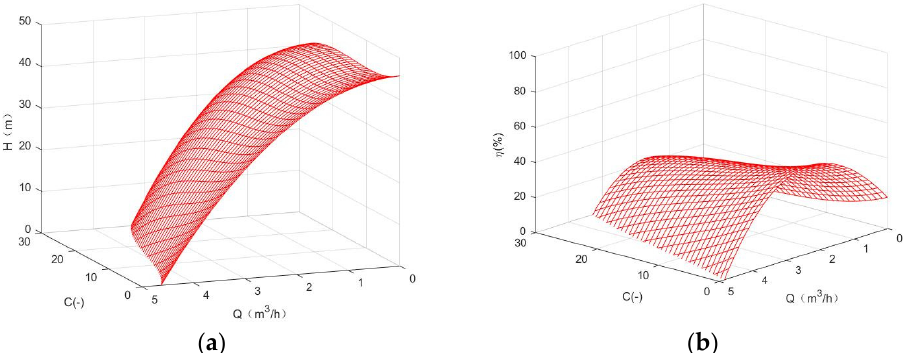
Figure 6. ( a ) Empirical function diagram of ice concentration and head and ( b ) ice concentration and pump efficiency.